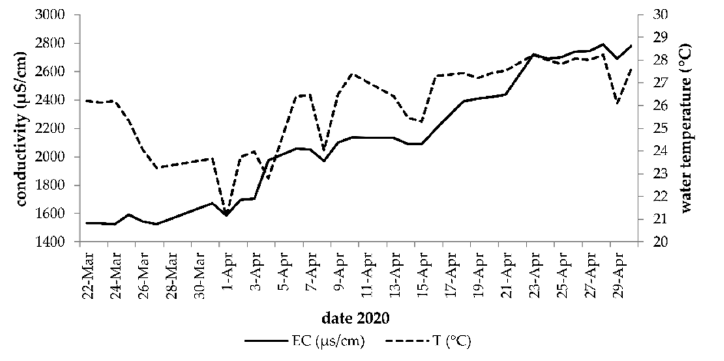
Figure 7. Electric conductivity (μs/cm) and water temperature (°C) increase during the experiment. The mean nitrate–nitrogen concentration (NO₃ − –N) was 164.54 mg/L and nitrite–ni- trogen (NO₂ − –N) 0.01 mg/L, which resulted in a concentration of 164.55 mg/L total oxi- dized nitrogen (TON). With an ammonium–nitrogen (NH 4+ –N) concentration of 0.05